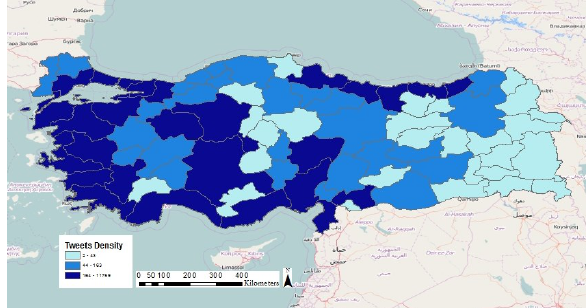
Figure 4. Tweet Distribution of Turkey (18 th and 20 th